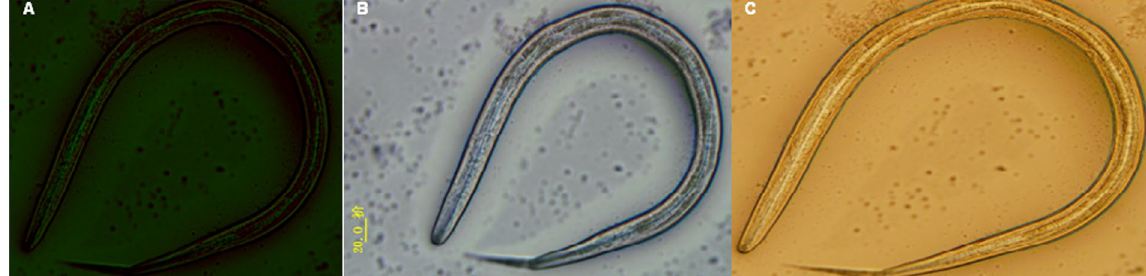
Figure 6. H. contortus showing internalized yellow fluorescent protein (YFP)-expressing Escherichia coli. Fluorescent ( A ), merged ( B ) and Bright ( C ) images were taken.